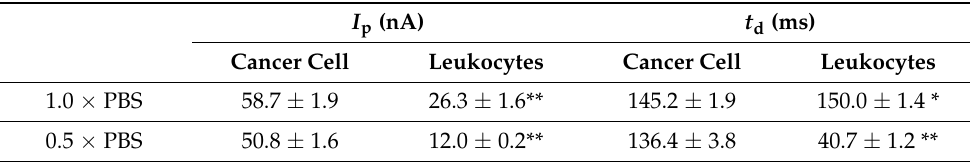
Table 2. Mean of I p and t d of each cell by RPM